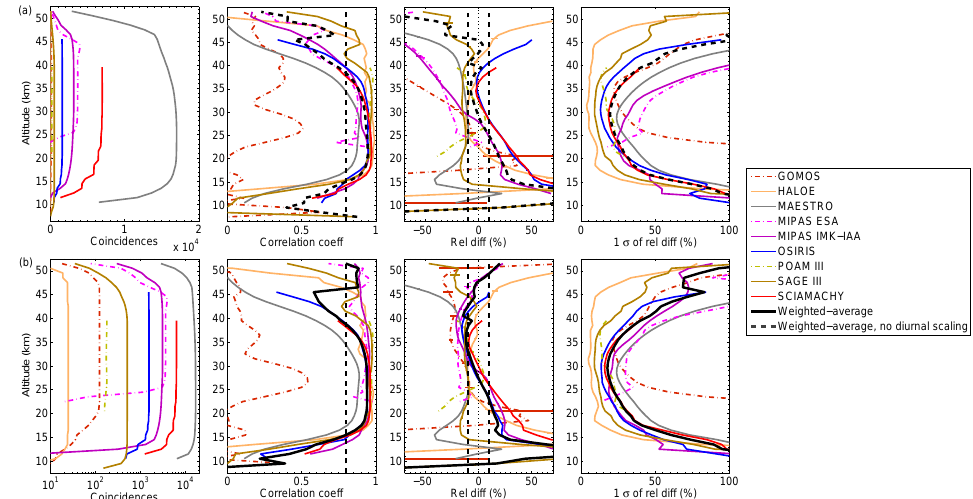
Figure 7. Comparisons of ACE-FTS NO 2 profiles with correlative data sets using coincidence criteria of within 4h and 350km. From left to right, the plots in each panel show number of coincident measurements, correlation profiles between ACE-FTS and INST, mean relative difference profiles (ACE-FTS − INST) in percent, and standard deviation of relative difference profiles in percent. (a) Comparisons without diurnal scaling; (b) comparisons with diurnal scaling. Error bars in the relative difference profiles represent the standard error of the mean (values less than ∼ 1% may not be visible).